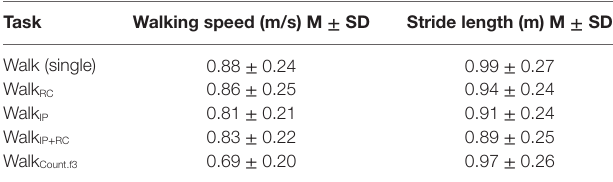
TaBle 3 | Gait parameters during single and dual tasks.